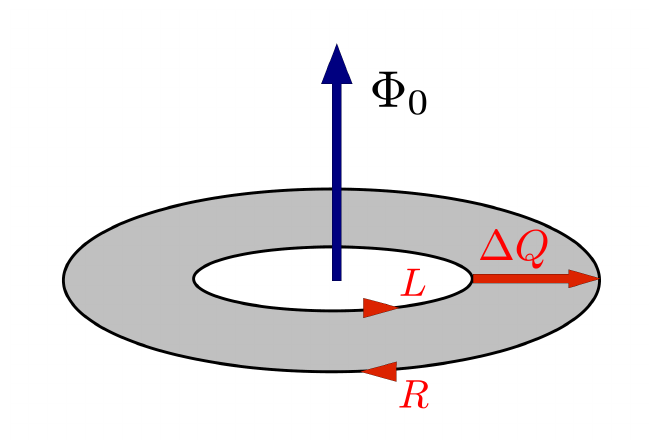
Figure 6: Laughlin flux argument: the adiabatic insertion of a flux quantum Φ annulus moves a charge ∆ Q = 1 from the inner to the outer